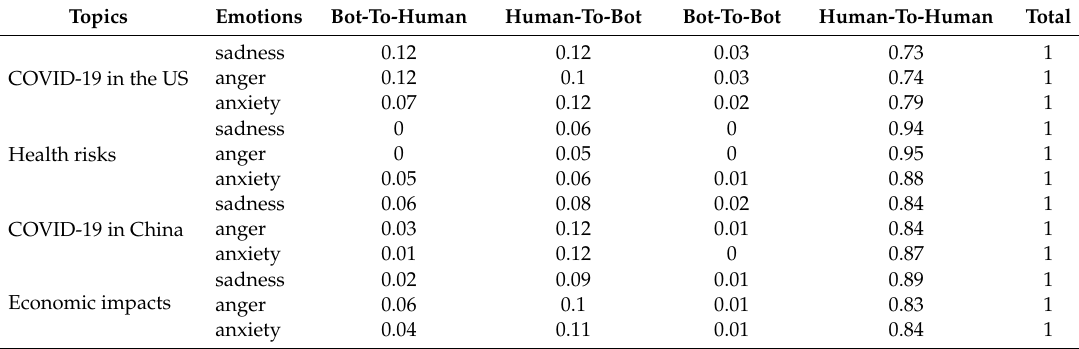
Table 4. Emotion transmission among di ff erent user groups for four topics of which their overall sentiments polarity was